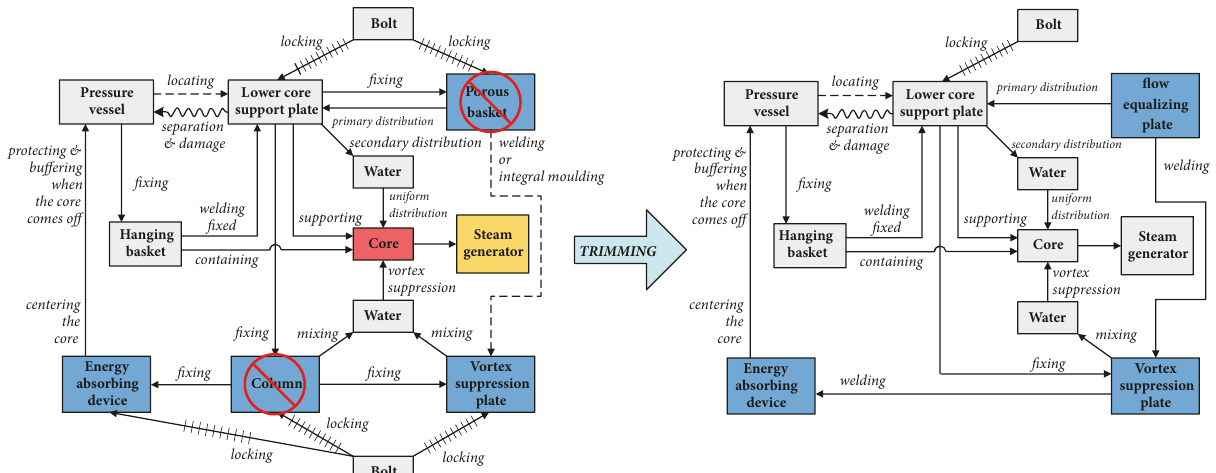
Figure 3: Trimming process of the PWR coolant flow distribution device.